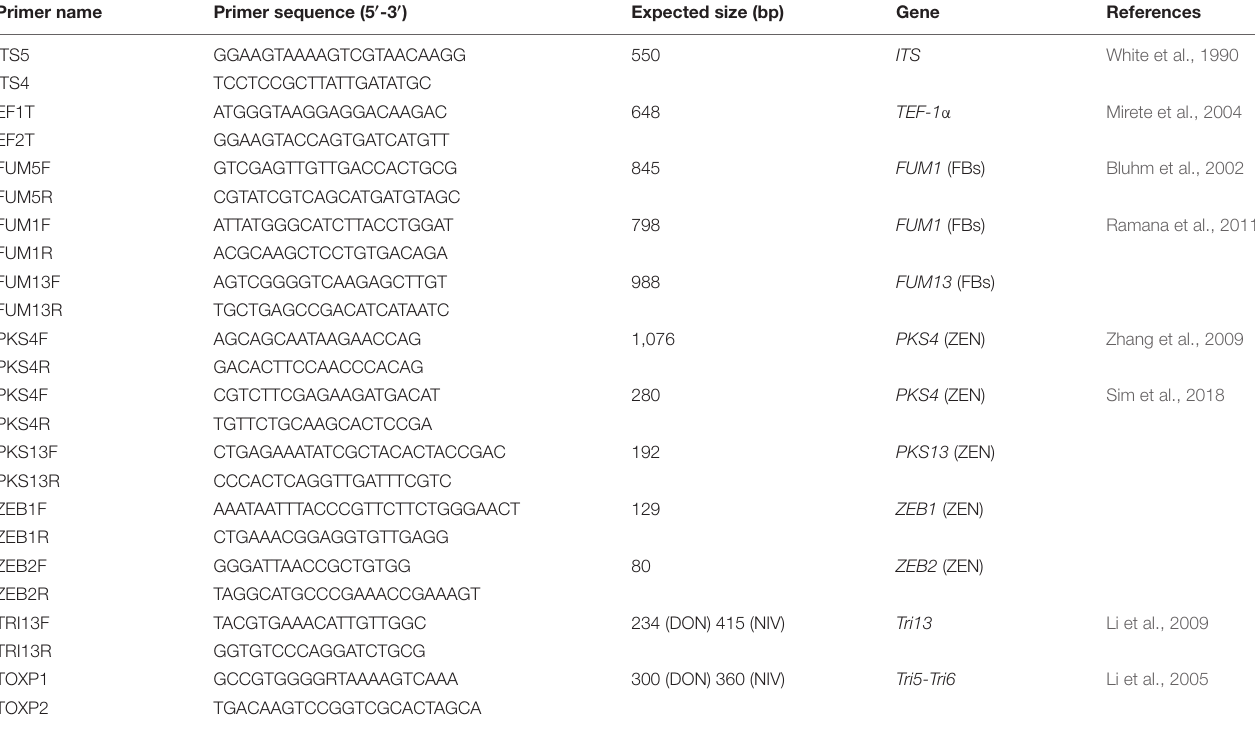
TABLE 1 | Information about primers used in the